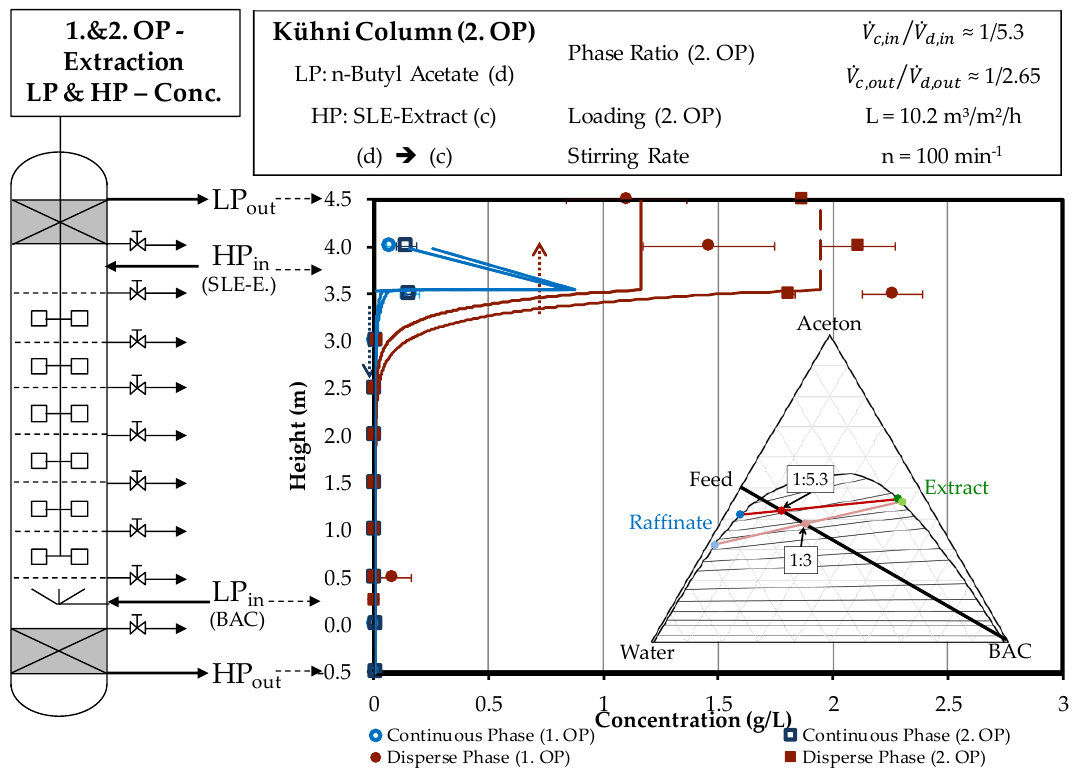
Figure 9. Comparison of model-based prediction of the steady-state concentration profile of artemisinin for the first and second operating point and the corresponding experiments. OP (operating point), BAC (butyl acetate), Conc. (concentration).